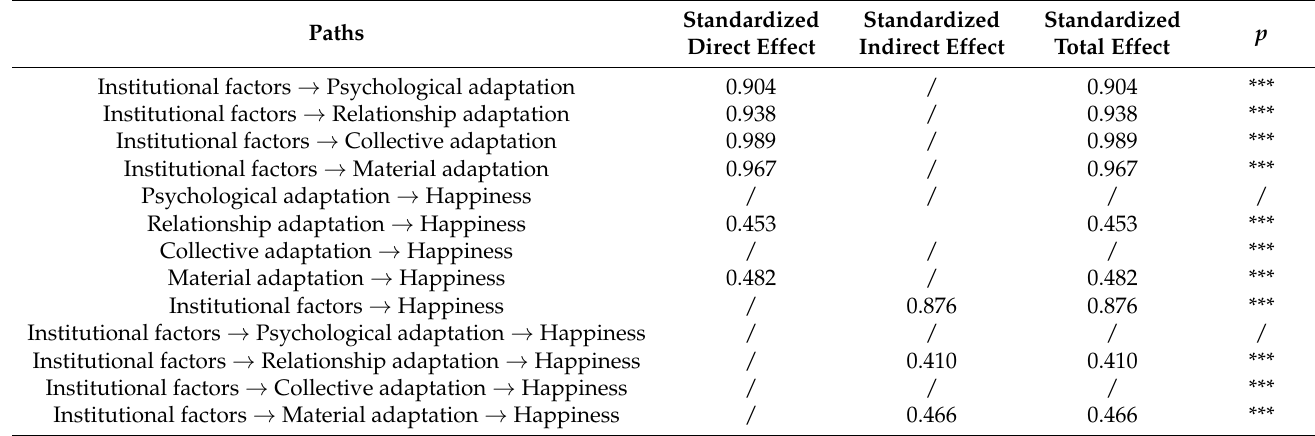
Table 7. The effects of institutional factors on the happiness of urban young returnees.